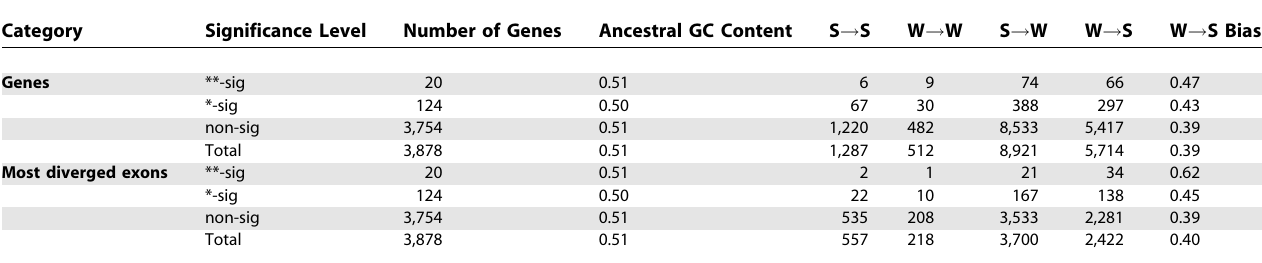
Table 8. Patterns of Nucleotide Substitution in Genes with Evidence for Positive Selection Based on MK Tests Category